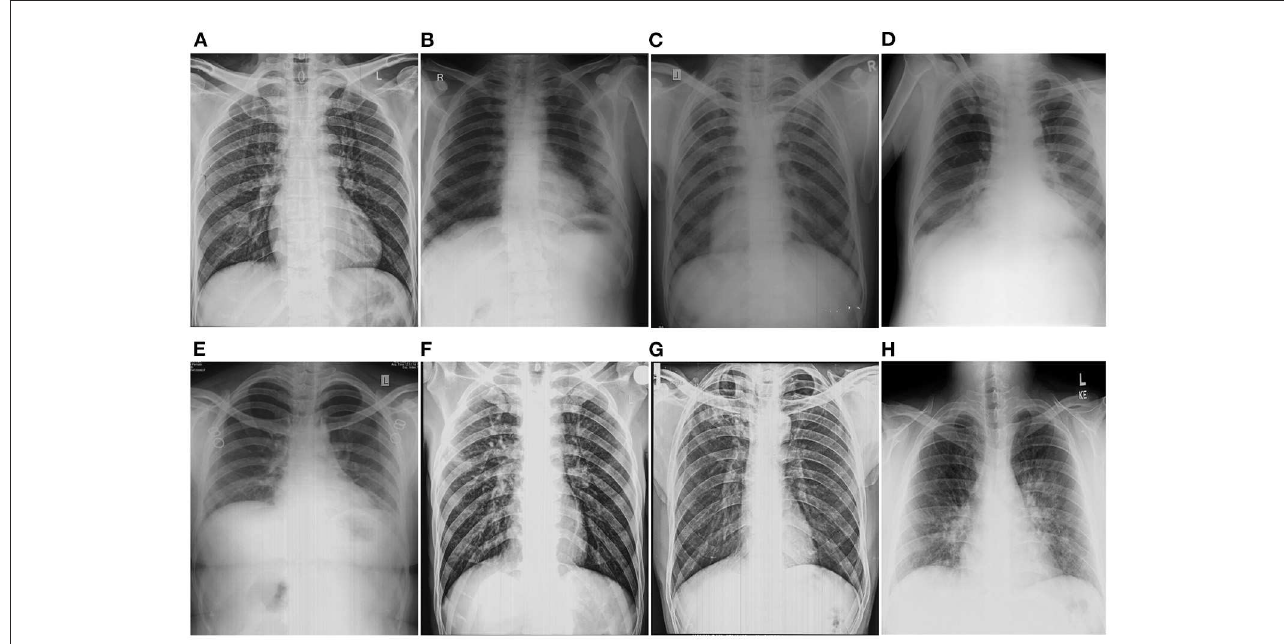
FIGURE7 Showcasing the chest-X rays affected with different lung disorders. (A) Normal, (B) Pneumoconoisis, (C) TB, (D) Pneumonia, (E) Bronchitis, (F) COPD, (G) Fibrosis, and (H) COVID-19.